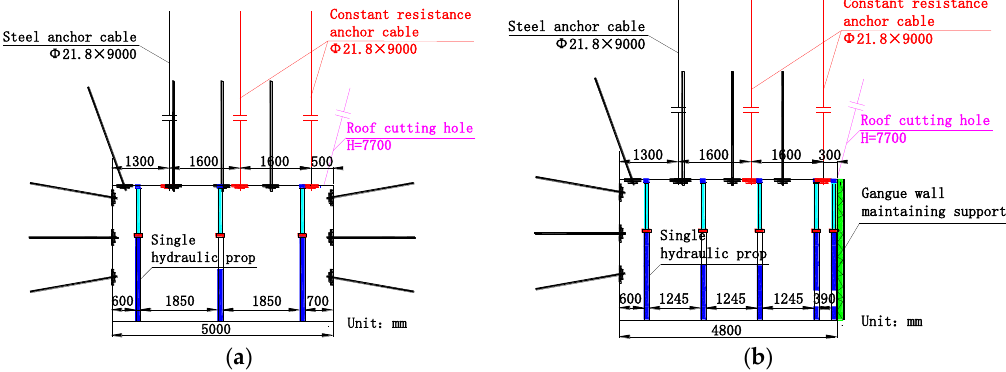
Figure 6. Design of temporary support: ( a ) Temporary support in front of the longwall; ( b ) Temporary support behind the long wall.